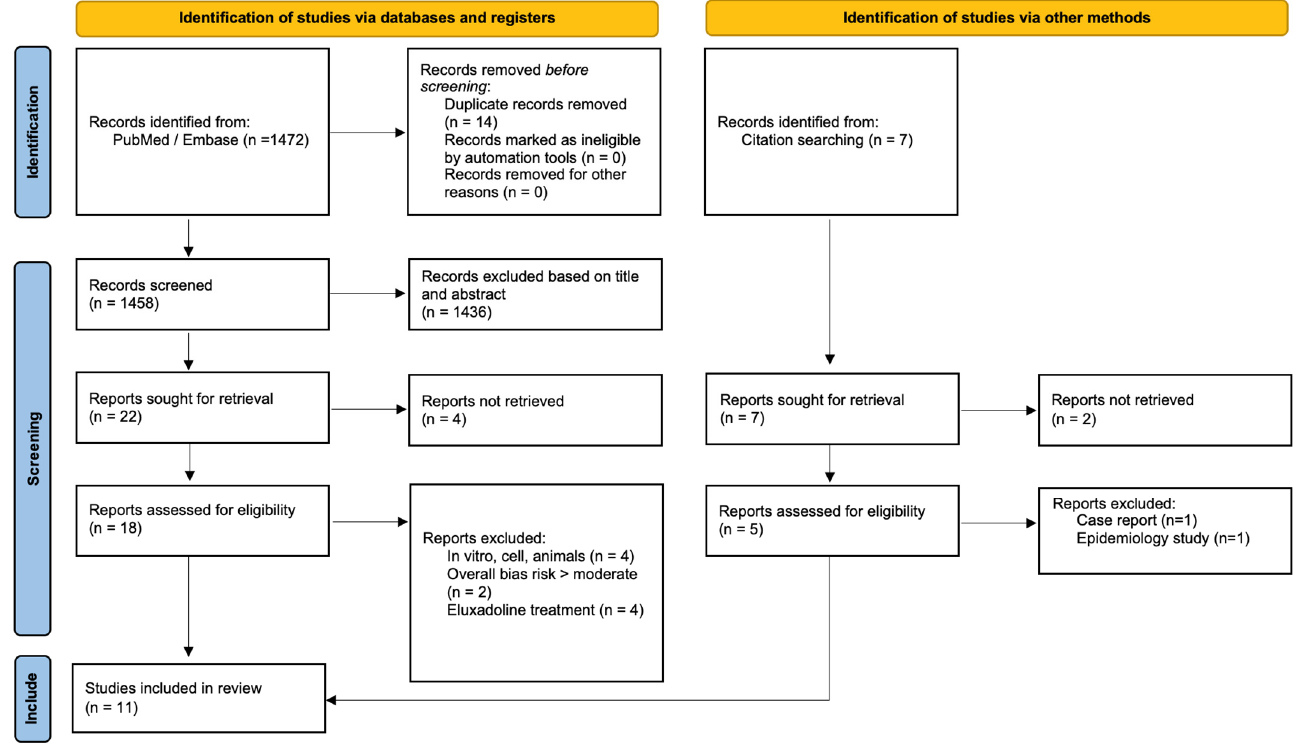
Figure 1. PRISMA fl ow diagram. Figure 1. PRISMA flow